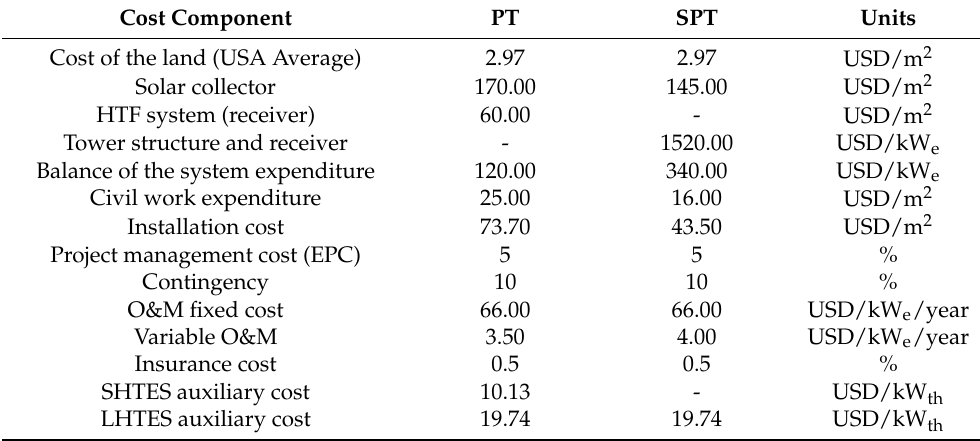
Table 2. Cost components considered in LCOE estimating of PT and SPT plants.